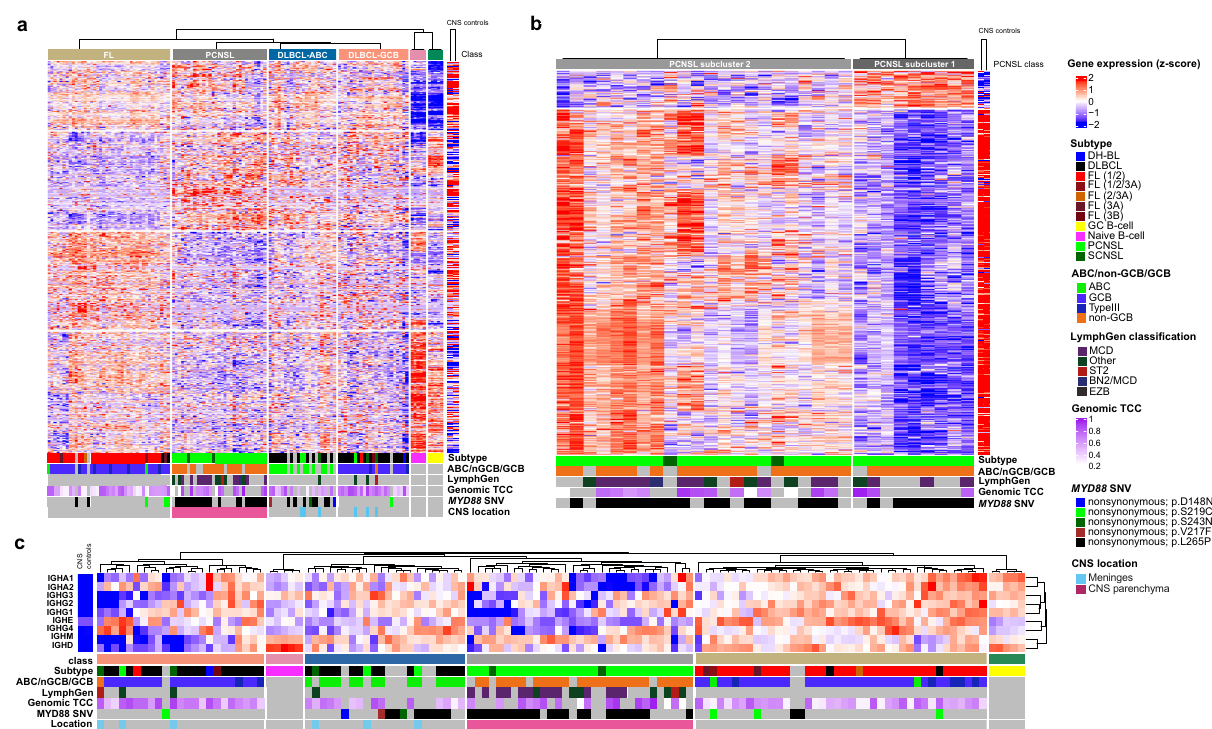
Fig. 7 Transcriptomic signatures distinguish PCNSL from DLBCL. Global gene expression patterns clearly separate PCNSL from other subtypes (ABC- DLBCL, GCB-DLBCL, and FL; a ). The heatmap shows unsupervised consensus clustering of gene expression data. All SCNSL-M and PCNSL-M cluster with non-CNS-DLBCL, distinct from intraparenchymal PCNSL. The ABC-DLBCL cluster is enriched for MYD88 mutant samples, which are distinct from MYD88 L265P mutant PCNSL. Samples of normal germinal center (GC) and naïve B-cells were included as controls. Furthermore, normal brain tissue (CNS controls) samples were added to analyze the impact of normal brain tissue contamination at the RNA level. Consensus clustering (skmeans) with intraparenchymal PCNSL samples and CNS controls revealed two groups ( b ). The fi rst PCNSL expression group (PCNSL subcluster 1, on the right) consisted of samples with high tumor cell content, the second (PCNSL subcluster 2, on the left) contained mainly samples with a lower tumor cell content, which signatures correlated well with normal brain tissue expression. PCNSL can be distinguished from ABC-DLBCL, GCB-DLBCL, and FL based on the expression of IG constant genes ( c The marker genes in each group were identi fi ed based on differential gene expression analysis (Supplementary Data 12).